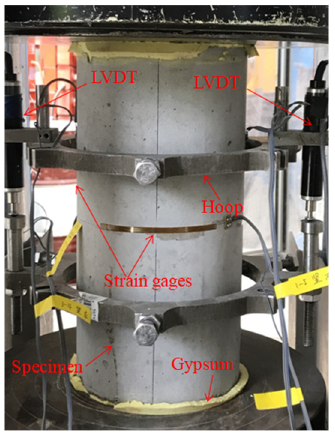
Figure 4. Experimental setup for SSC compressive test.